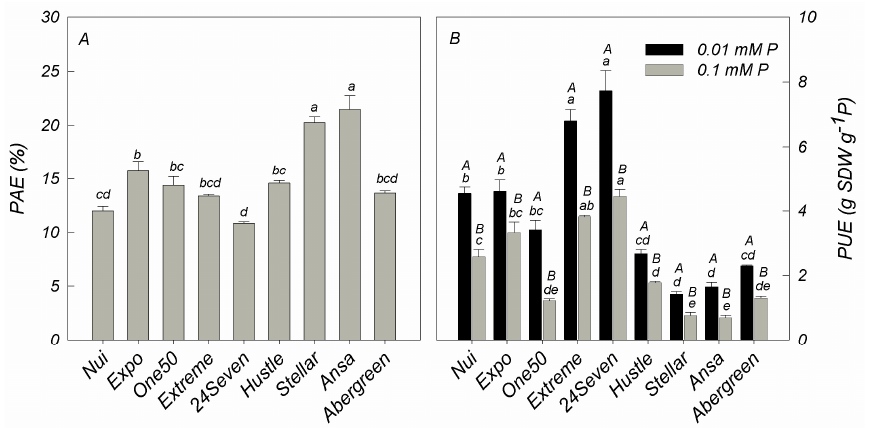
Figure 2. Phosphorus acquisition efficiency (PAE; ( A )) and phosphorus utilization efficiency (PUE; ( B )) in different ryegrass cultivars hydroponically grown at optimal (0.1 mM P) and deficient (0.01 mM P) P conditions. Values represent the mean (n = 3) ± standard error. Different uppercase letters indicate statistically significant differences (Tukey’s HSD at p ≤ 0.05) between P treatments for the same cultivar. Different lowercase letters indicate statistically significant differences (Tukey’s HSD at p ≤ 0.05) among ryegrass cultivars at the same P treatment.